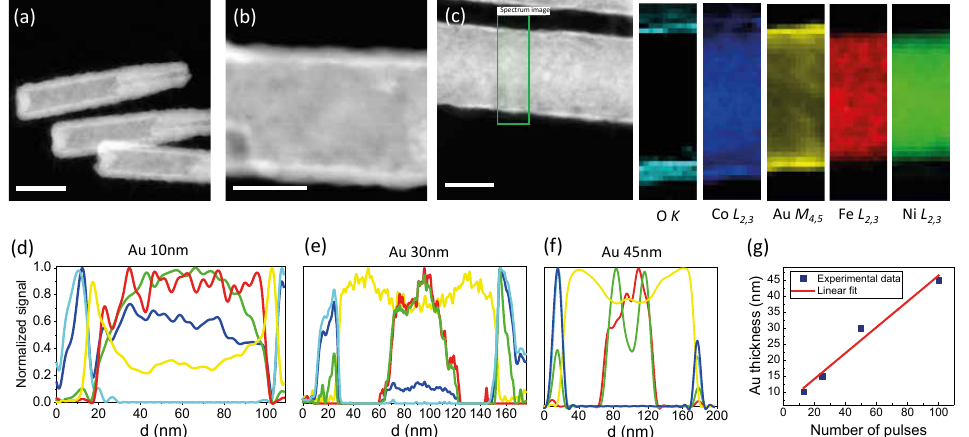
Figure 2. STEM-EELS characterization of the NWs. ( a , b ) High-angle annular dark-field images of the nanostructures at low and high magnification. ( c ) EELS spatial compositional maps showing the O, Au, Co, Fe and Ni content within the region marked with a green rectangle in the image. ( d – f ) From left to right, EELS line scans showing the elemental profiles for different samples with increasing Au shell thickness. ( g ) Calibration curve of the Au shell thickness as function of the number of repetitions of on/rest pulses. The scale bar is 50 nm for all